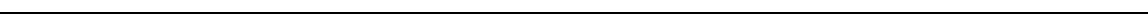
Fig. 1 K63-linked ubiquitination promotes YAP nuclear localization and activity. a HEK293T cells were transfected with SFB-YAP and HA-ubiquitin (wild- type, K48 or K48R) and then subjected to a pulldown assay with S-protein beads and immunoblotting with antibodies against HA and FLAG. H: high density; L: low density. b HEK293A cells were stably transfected with SFB-YAP and then subjected to a pulldown assay with S-protein beads and immunoblotting with antibodies against K63-linkage-speci fi c polyubiquitin, p-YAP (S127) and FLAG. H: high density; L: low density. c Total K63-linkage speci fi c ubiquitinated proteins in MCF10A cells were immunoprecipitated by a K63-linked polyubiquitin-speci fi c antibody, followed by immunoblotting with antibodies against YAP and ubiquitin. H: high density; L: low density. d HEK293T cells were transfected with SFB-YAP (wild-type, K321R, K497R, or K321R/ K497R) and the K63-speci fi c mutant of HA-ubiquitin and then subjected to a pulldown assay with S-protein beads and immunoblotting with antibodies against HA and FLAG. e Upper panel: YAP knockout HEK293A cells (generated by CRISPR-Cas9) were transfected with SFB-YAP (wild-type or K321R/ K497R) and immunostained with a YAP-speci fi c antibody (green). DAPI (blue) was used to stain DNA. Lower panel: immunoblotting of YAP (left) and quanti fi cation of immuno fl uorescence data (right). Statistical signi fi cance was determined by a chi-square test. * P < 0.05; ** P < 0.01; *** P < 0.001. Scale bar, 20 μ m. f Luciferase activity in HEK293T cells co-transfected with SFB-YAP (wild-type or K321R/K497R), an 8×GTIIC luciferase reporter and a TK- Renilla luciferase reporter. n = 3 biological replicates. g qPCR of ANKRD1 , CTGF , and CYR61 in cells described in f . n = 3 biological replicates. Error bars in